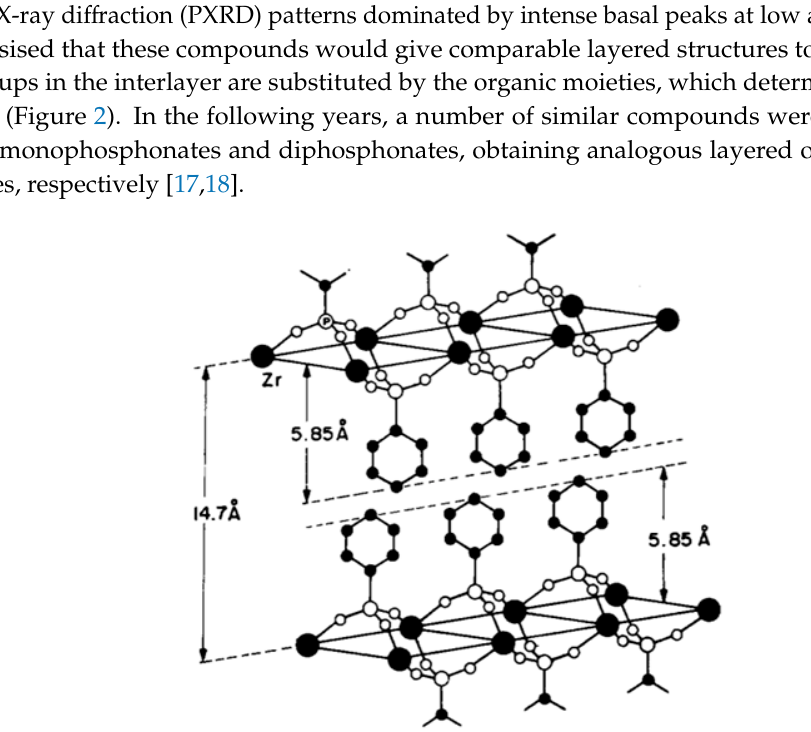
Figure 2. Idealised structural model of Zr(C 6 H 5 PO 3 ) 2 . Reprinted with permission from reference [16]. Copyright 1978, Elsevier Inc.